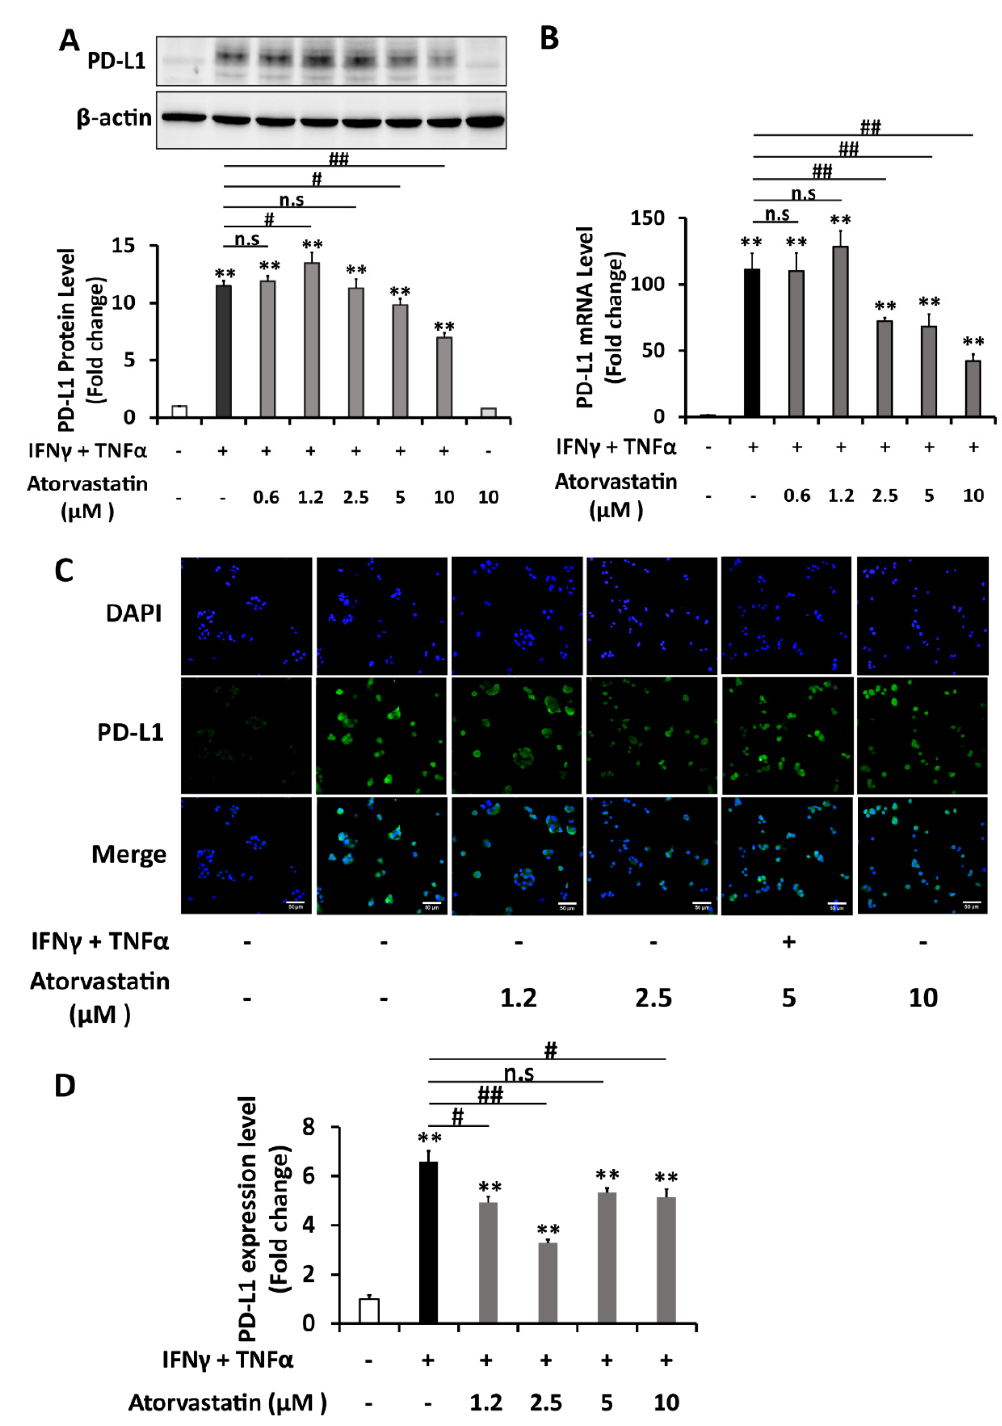
Figure 8. Atorvastatin reduces the induction of PD-L1 expression by IFN γ and TNF α combined treatment in HepG2 cells. ( A – D ) Analysis of PD-L1 expression of HepG2 cells co-treated with a combination of IFN γ 1 ng/mL+TNF α 10 ng/mL and atorvastatin at various concentrations ( µ M) for 6 h in RT-PCR analysis, and for 24 h in western blot and immunocytochemistry analysis. (A) Western blot analysis and quantification. β -actin was used as a loading control. ( B ) RT-PCR analysis. Relative PD-L1 mRNA level was normalized to the expression of the GAPDH gene. ( C , D ) Immunocytochemistry of PD-L1 membrane expression and its quantification. Scale bar = 50 µ m. Data are presented as mean ± SD for WB and RT-PCR; mean ± SEM for immunocytochemistry. n = 3. * p < 0.05, ** p < 0.01 compared to control. # p < 0.05, ## p < 0.01 compared to IFN γ and TNF α combined treatment.